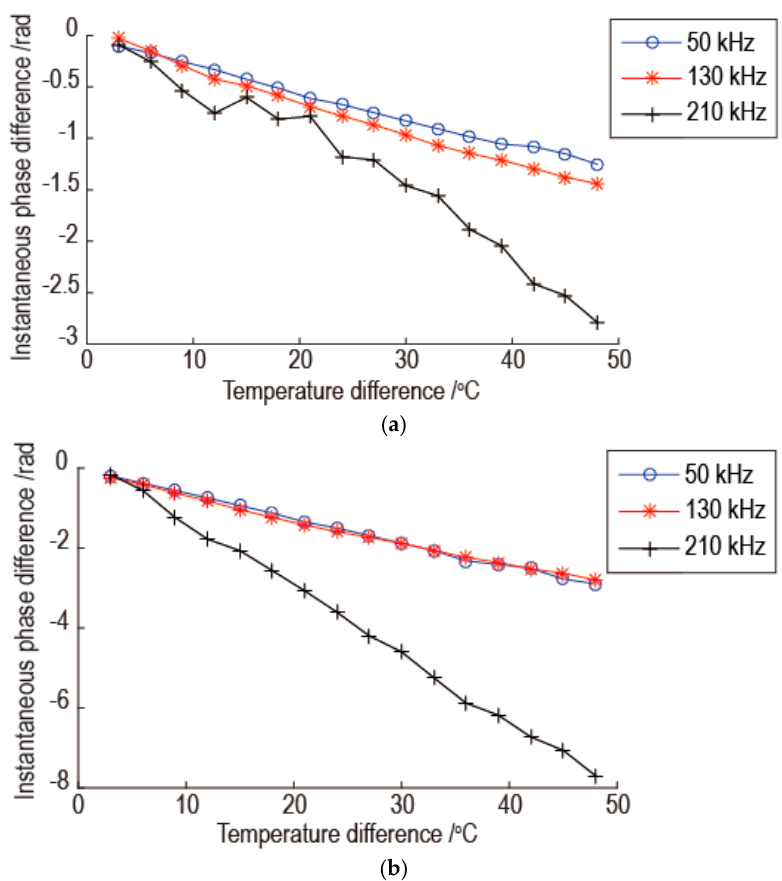
Figure 8. The comparison of the relationship between the instantaneous phase difference and the temperature difference for same signal point at different frequency: ( a ) Signal point at 0.2 ms; ( b ) Signal point at 0.4 ms.